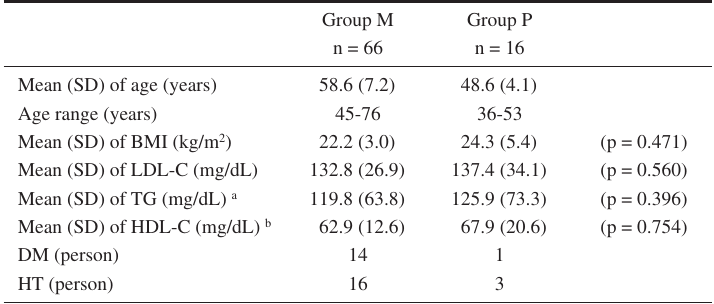
BMI, body mass index; LDL-C, low-density lipoprotein cholesterol; HDL-C, high- density lipoprotein cholesterol; TG, triglyceride; DM, diabetes mellitus; HT, hyperten- sion; SD, standard deviation; Group M, postmenopausal patients; Group P, non-post- menopausal patients; p, p-value of the unpaired t -test.